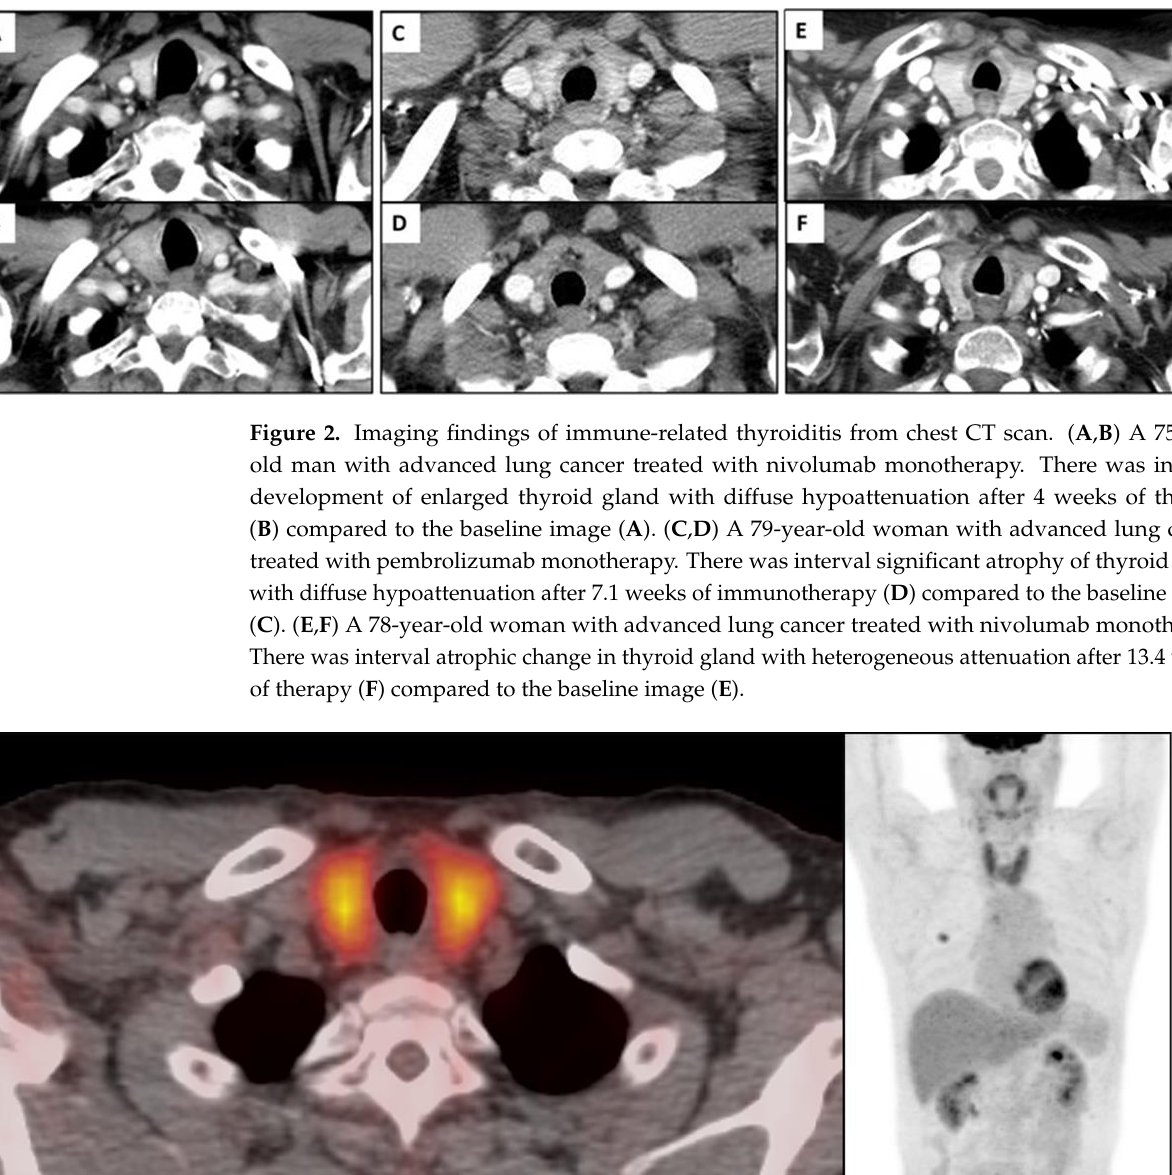
Figure 1. Flow chart for the radiologic review of readers. A total of 50 patients (marked as asterisks) showed CT findings indicative of immune-related thyroiditis.